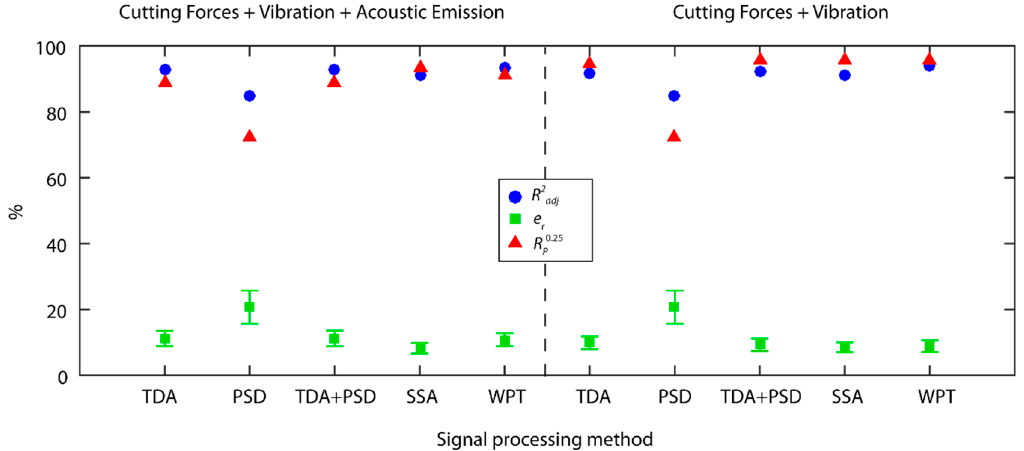
Figure 18 . Comparison of the prediction results obtained with multi-sensor data fusion with and without the acoustic emission signal.